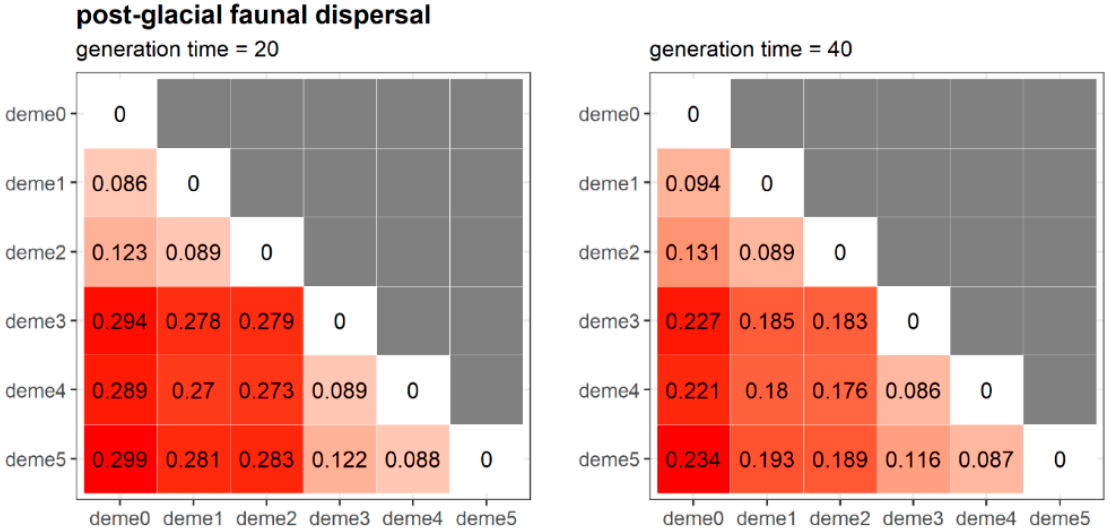
Figure A1. The mean pairwise Fst values calculated across 100 replicate simulations of a post-glacial faunal-mediated dispersal scenario (“fd” in Table A1). This scenario of faunal dispersal assumes a symmetric distance-weighted migration matrix.